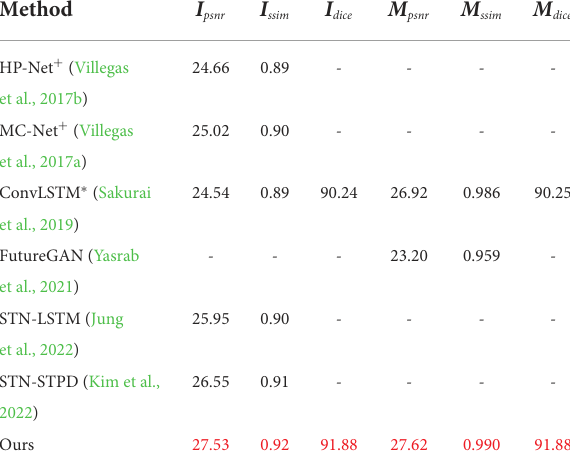
TABLE 3 Performance comparisons with other methods.